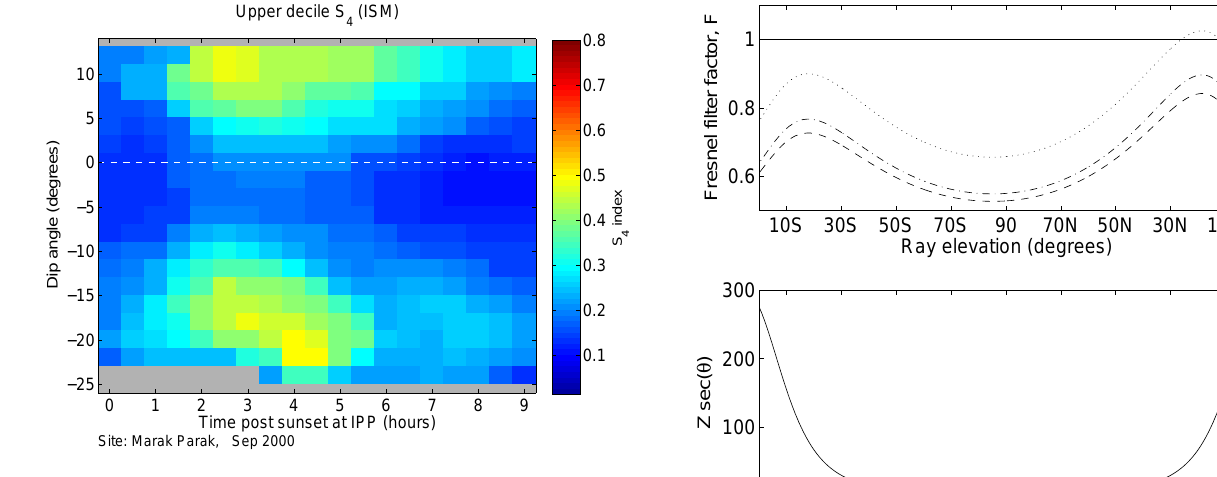
Fig. 9. Upper decile slant S 4 index at Marak Parak during Septem- ber 2000. The dashed line indicates the magnetic equator.